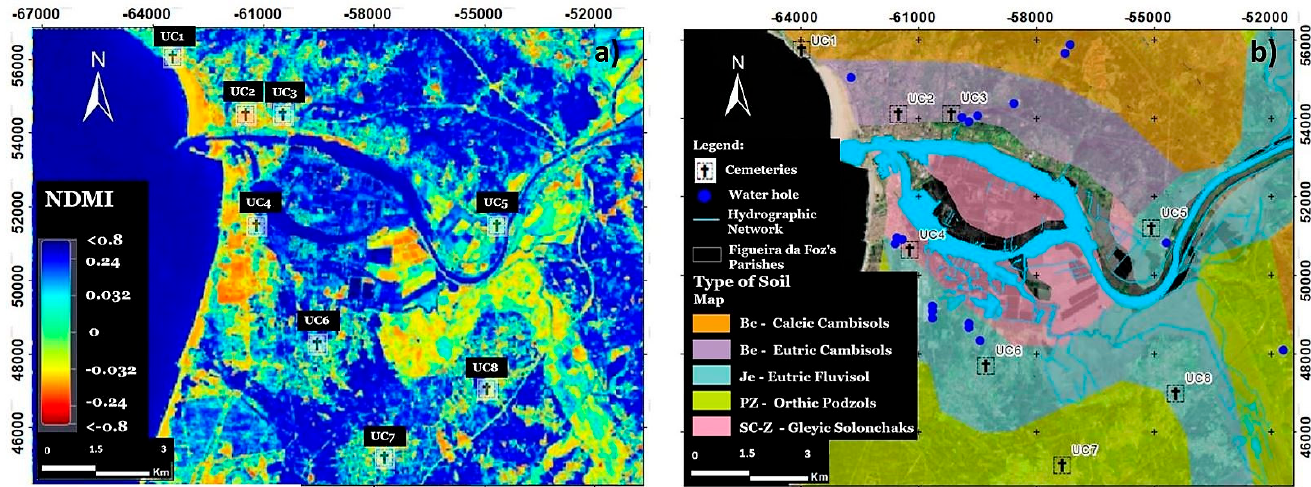
Figure 7. a ) NDMI; b ) characteristics of soil in the upper weathered